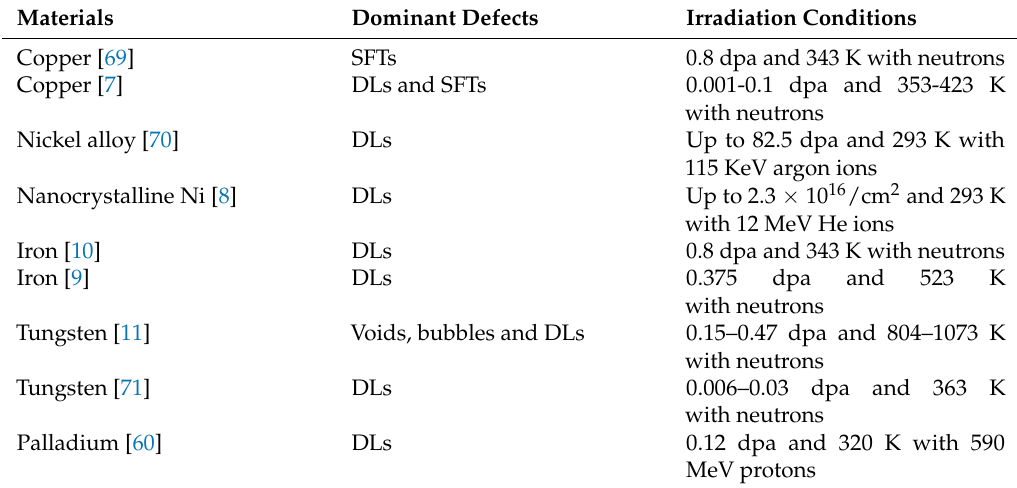
The dominant irradiation-induced defects observed in different types of nuclear structural